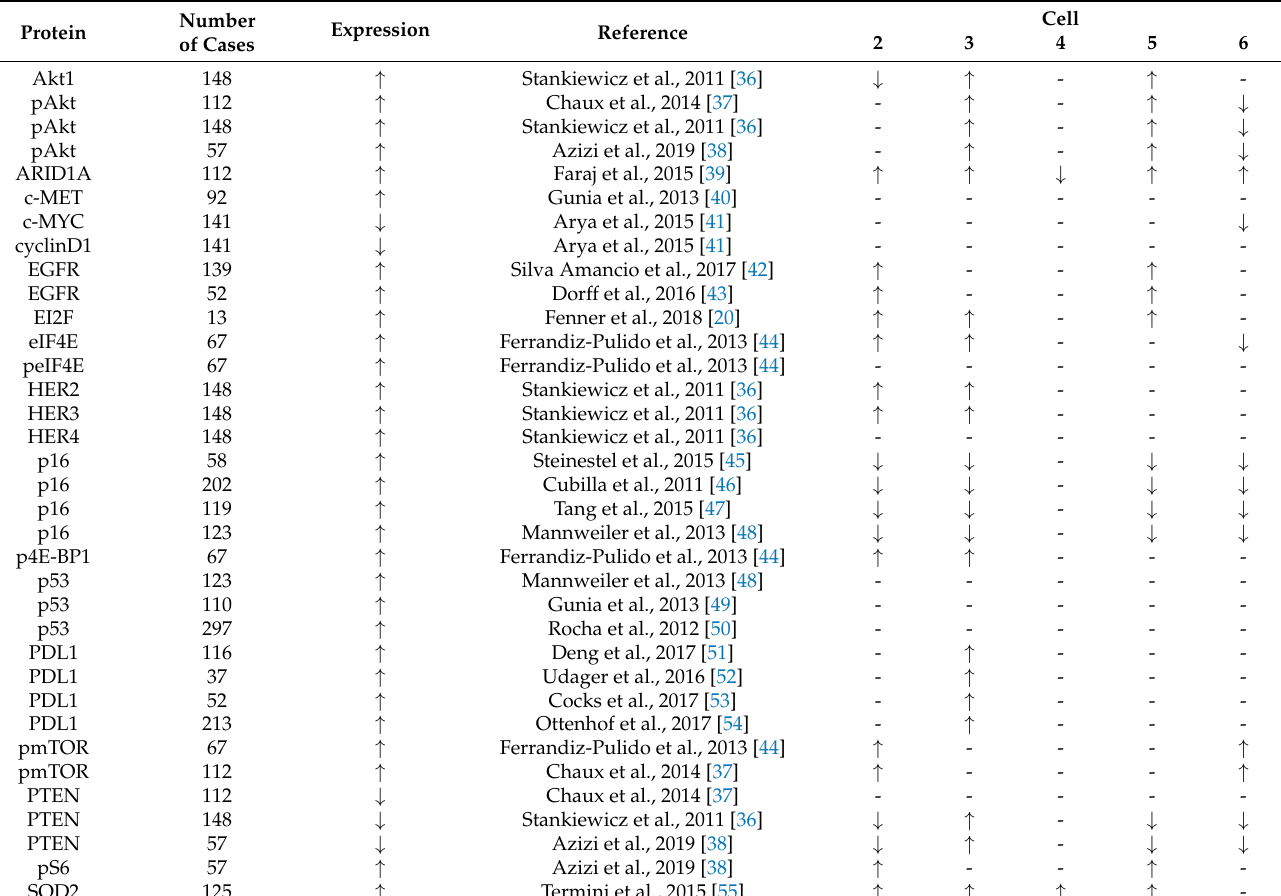
Table 4. Summary of the studies in penile cancer that evaluated the expression (immunohistochemistry or immunofluores- cence) of the same proteins presented in our RPPA (reverse-phase protein arrays) analysis.